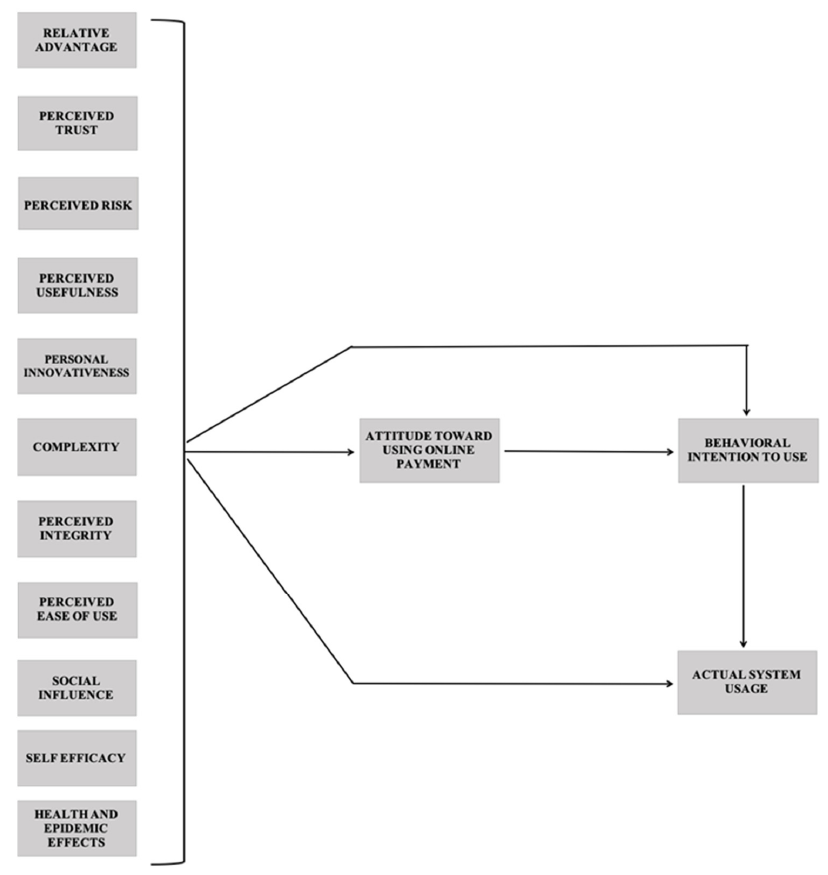
Figure 1. Proposed research